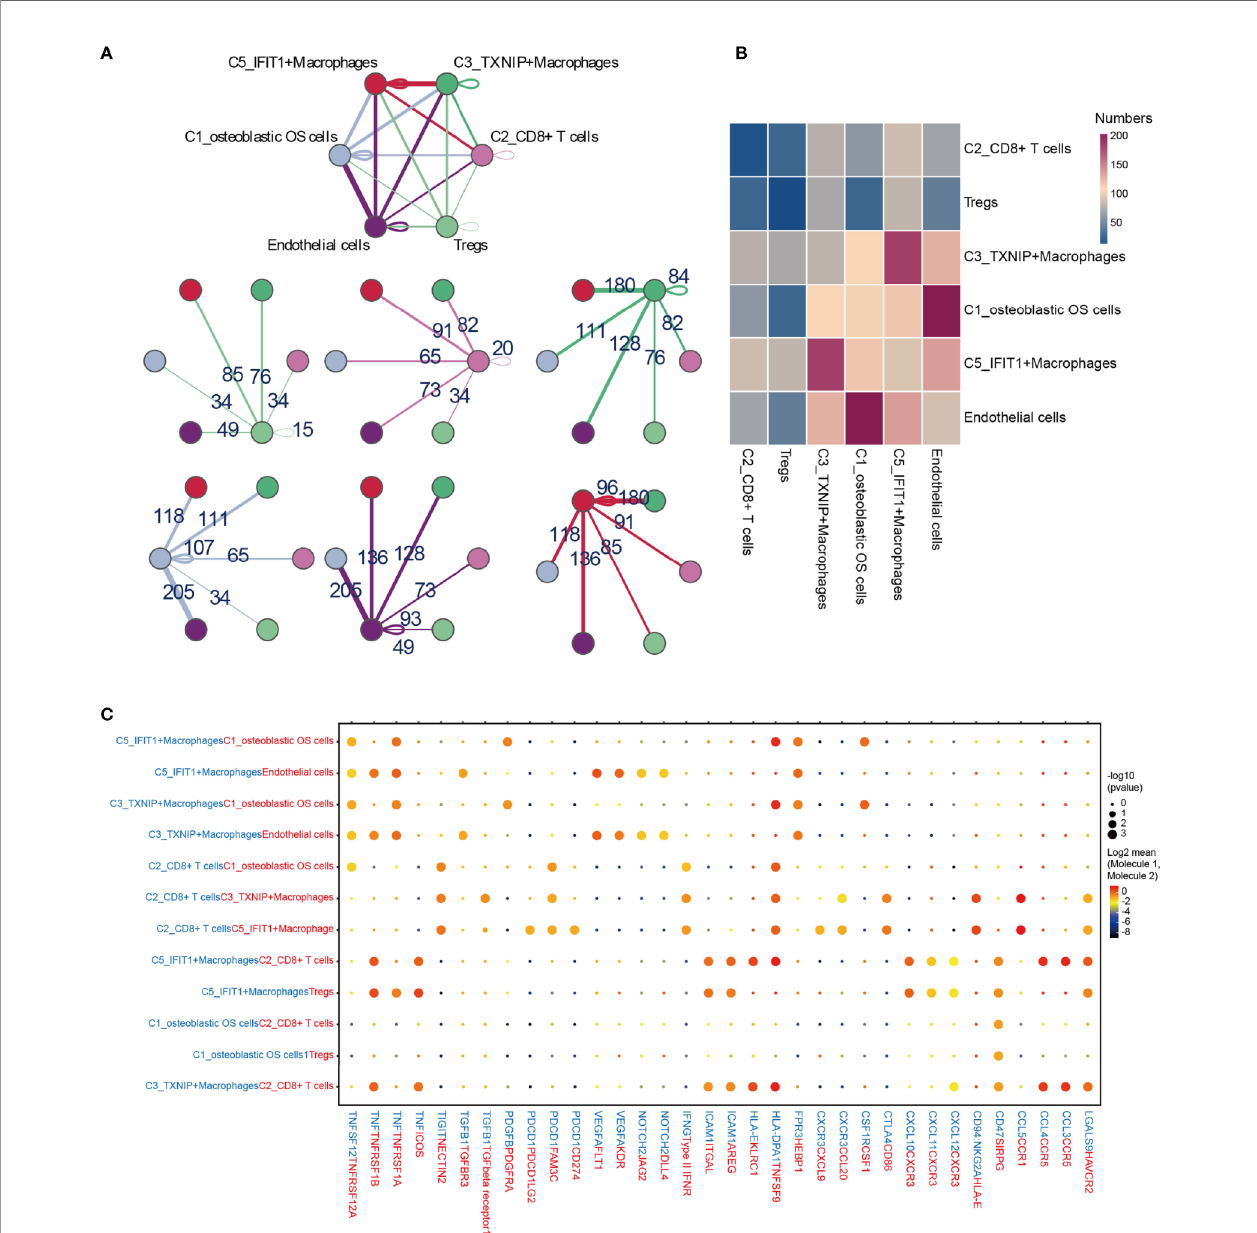
FIGURE 9 | CellPhoneDB analysis of immune cells in the OS. (A) Interaction network constructed by TXNIP + macrophages, IFIT1 + macrophages, osteoblastic OS cells, endothelial cells, Tregs and CD8 + T cells 2. (B) Heat map showing the potential ligand-receptor pairs among the predicted cell types. (C) Ligand-receptor pairs with a biological signi fi cance are shown in bubble diagrams. OS,